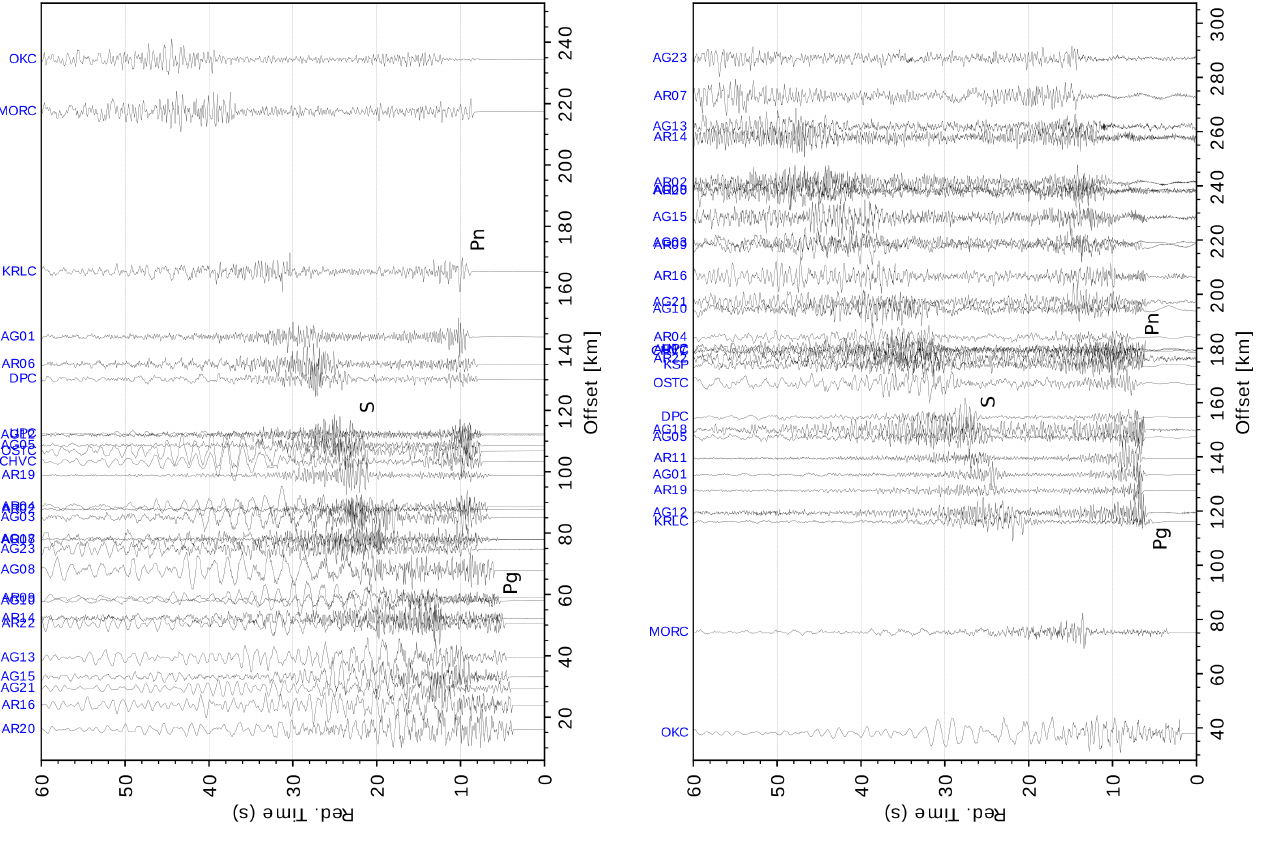
Figure 8. Example of waveforms recorded for the M4.4 local earth- quake which occurred 3 July 2018, 19:38:47.75UTC in Legnica- Głogów Copper District (lat: 51.5145, long: 16.1378, depth: 0.0km after ISC). A band-pass filter of 0.2–15Hz was used. Reduction ve- locity is 8km/s. Location of the epicentre is shown in Fig. 2.